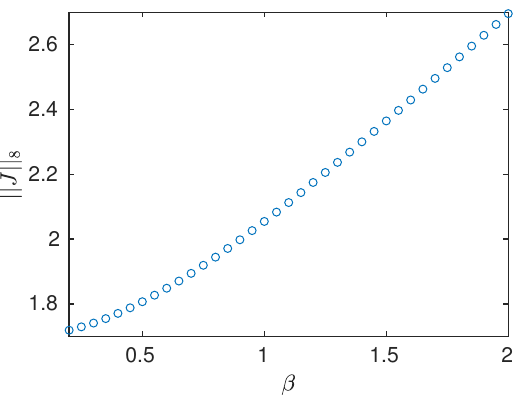
Figure 10. Variation of the norm as in Equation (35) against β , for T =